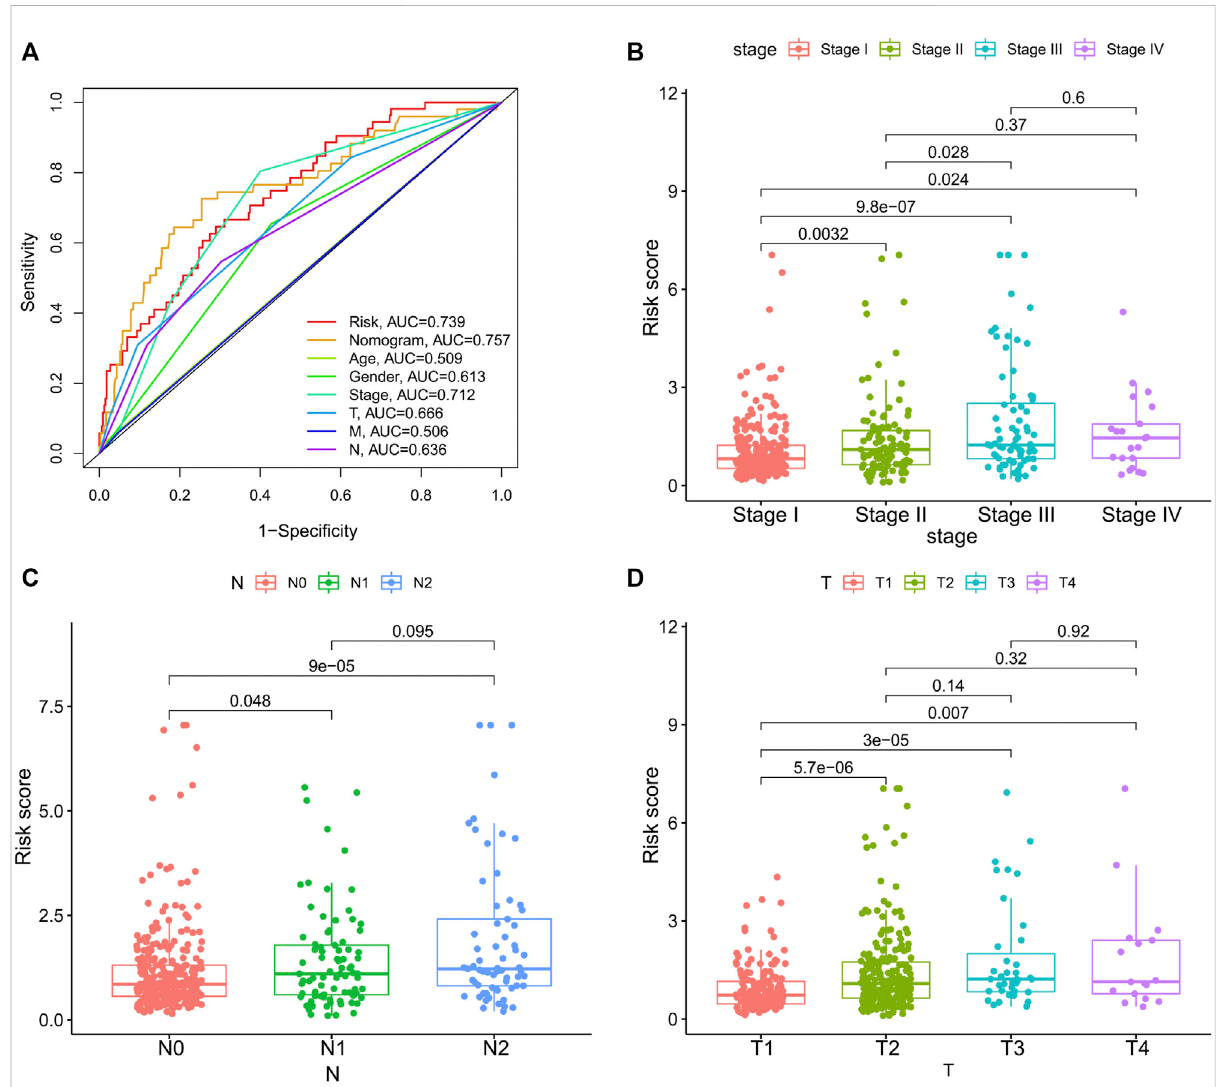
FIGURE 7 The associations betweenriskscore and clinicopathologicfactors. (A) , Multiindex ROCcurveofriskscore andother indicators. The association of risk score and stage (B) , N, lymphatic involvement (C) , and T, degree of tissue involvement (D)